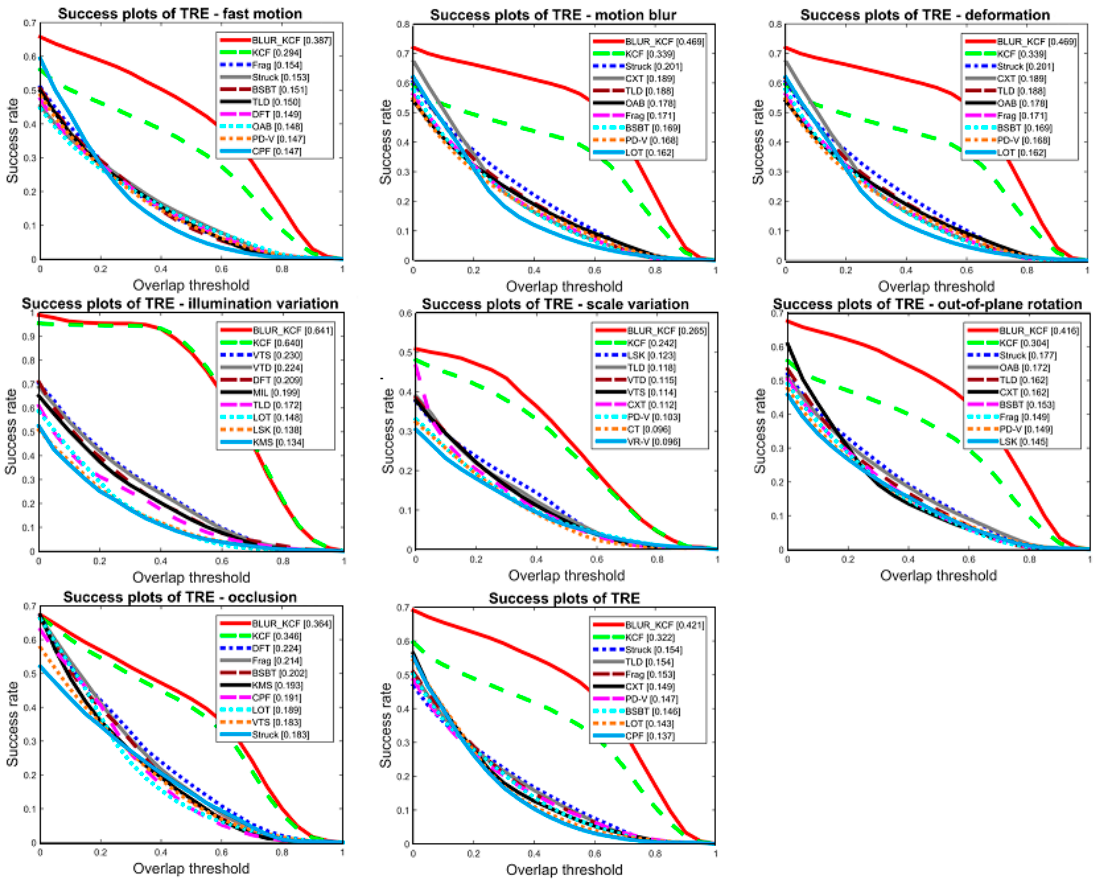
Figure 3. Overall performance in public datasets. These figures show the performance of trackers handing with fast motion, motion blur, deformation, illumination variation, scale variation, out-of- plane rotation and occlusion. The last figure shows the TRE success rate of these trackers under different threshold. Table 1. Average center location error compared with other top